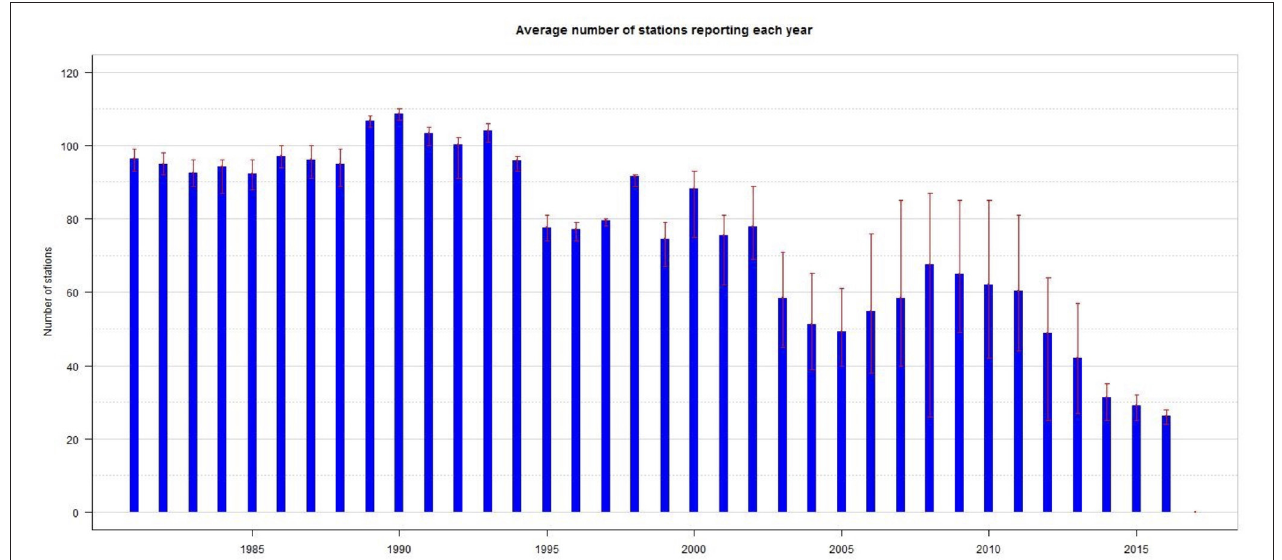
FIGURE 2 | Average number of stations that reported data for each